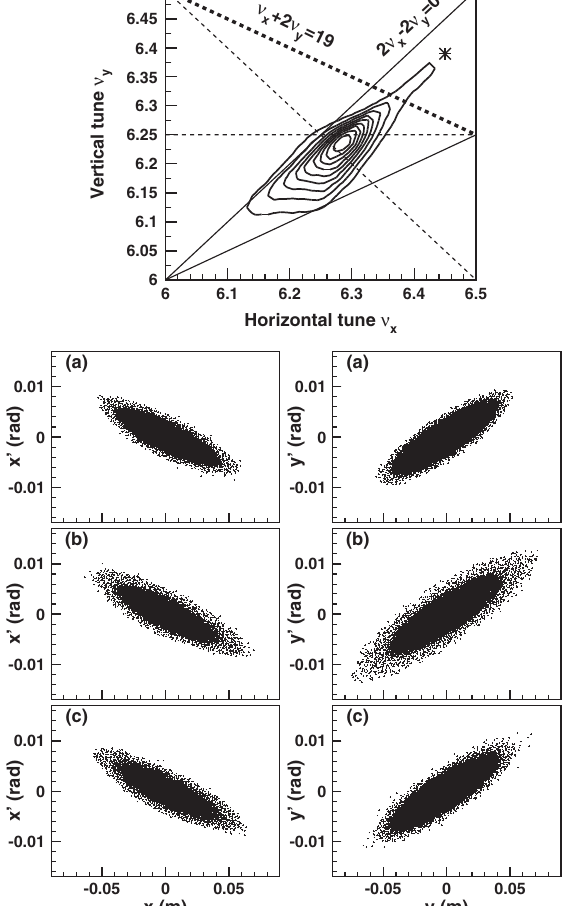
FIG. 18. Similar results to those in Fig. 11, calculated with a beam intensity of 740 kW in the case of the painting emittance of 150 π mm mrad: (a) without edge focus, (b) with edge focus, and (c) with the addition of QDTs to